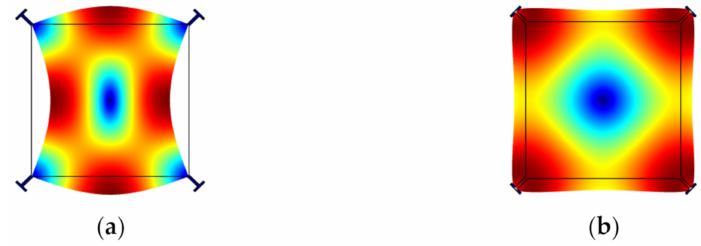
Figure 1. Finite element model (FEM) simulation of a BAW resonator with square plate structure in COMSOL. ( a ) WG mode; ( b ) Extensional mode.